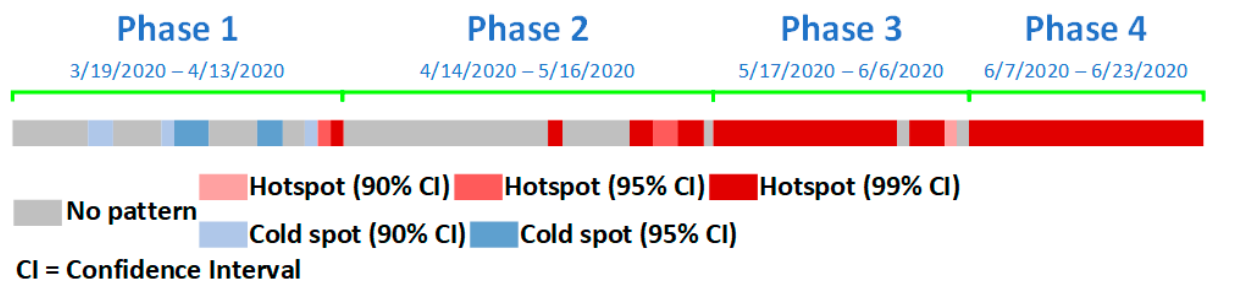
Figure 6. Illustration of a bin representative that has hotspot and cold spot appearance patterns. The classification of z -score values with a CI between 90% and 99% hotspots/cold spots is the same in each phase. In phase 2, there is no hotspot/cold spot 52% of the time, starting from the beginning of the phase; however, a hotspot appeared the next day with